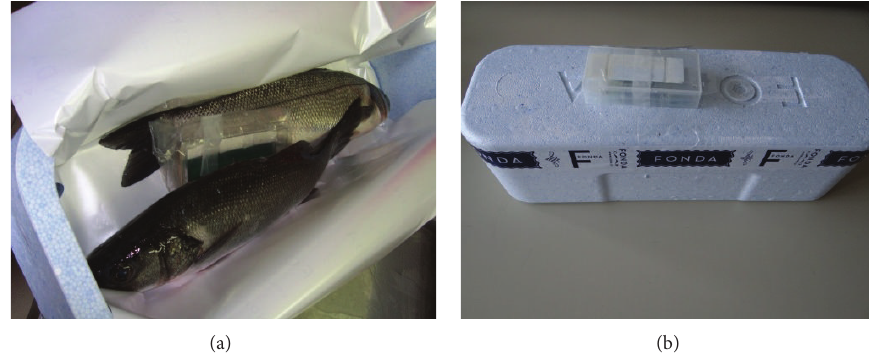
Figure 7: RFID-TL (a) is placed between the fish; (b) closed styrofoam box.